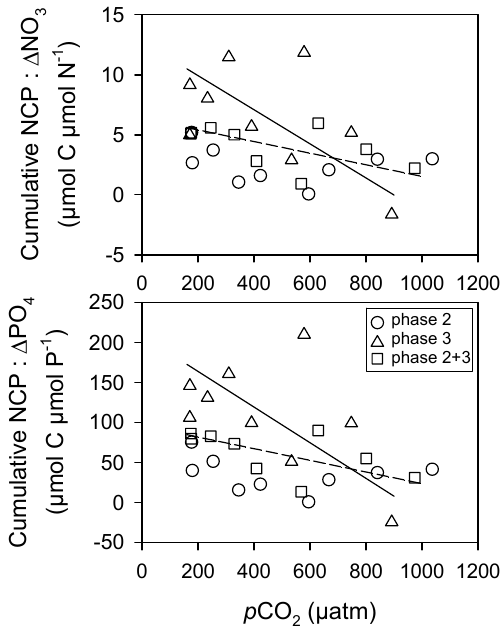
Fig. 3. Relationships between ratios of NCP (µmol CL − 1 d − 1 ) to cumulative consumption of NO 3 (µmol NL − 1 ) and PO 4 (µmol PL − 1 ) vs. the mean p CO 2 (µatm) during phase 2 (nutrient addition until the second chlorophyll minimum: t 14 to t 21) (circle), phase 3 (the second chlorophyll minimum until the end of this study: t 22 to t 28) (triangle), and phase 2 + 3 (after nutrient addition: t 14 to t 28) (square). NCP values based on changes of dissolved oxygen concentration were converted to carbon unit under an assumption of photosynthetic quotient of 1.25 (Williams et al., 1979). The solid and dotted lines indicate statistically significant relationship during phase 3 and phase 2 + 3, respectively (F-test, P <